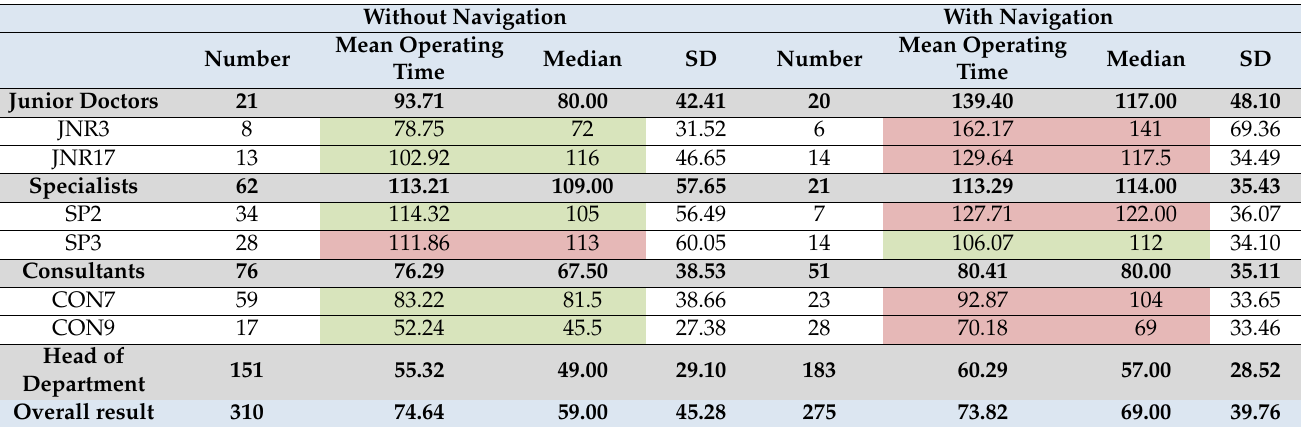
Table 7. Operations performed, reduced to those physicians most frequently